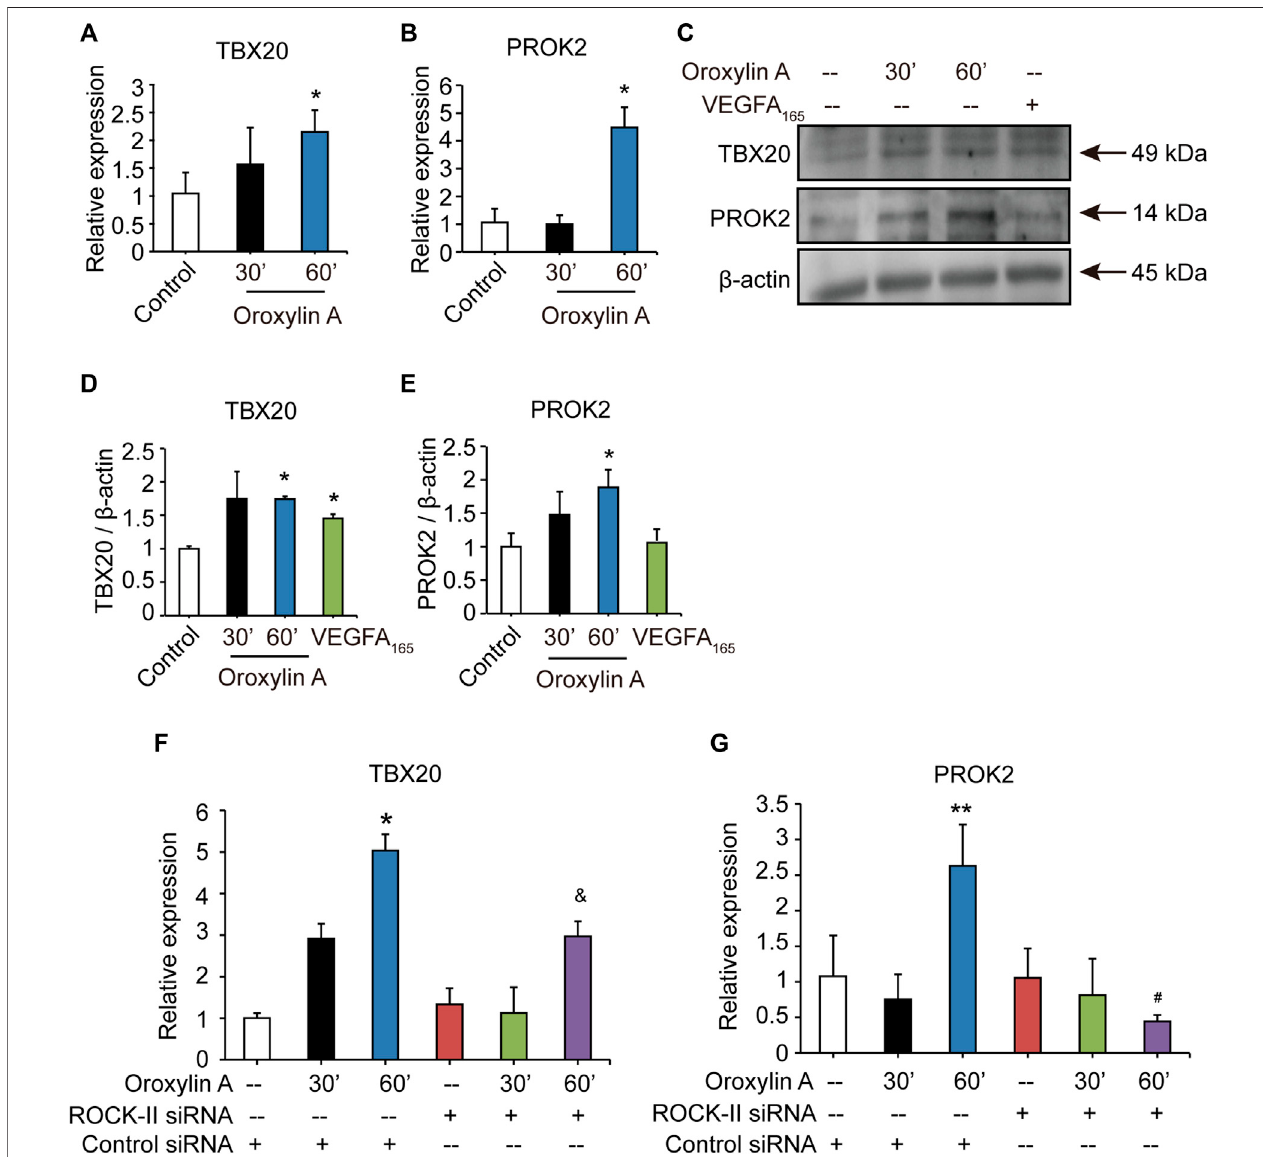
FIGURE 6 | OA regulated TBX20/PROK2 signaling pathway. Western blotting analysis of TBX20 or PROK2 in HUVECs stimulated with DMSO, 2.5 μ M OA (30, 60 min) and VEGFA 165 (100 ng/ml), β -actin expression an internal control of protein loading was performed, with VEGFA 165 as a positive control (A) . Quantitative data included TBX20 (B) and PROK2 (C) . TBX20 (D) and PROK2 (E) mRNA expression in HUVECs treated with DMSO or 2.5 μ M OA for 30, 60 min were analyzed using qRT-PCR.Statisticalanalysisof TBX20 (F) and PROK2 (G) mRNAofHUVECstransfectedwithnon-speci fi csiRNAorROCK-IIsiRNAandstimulatedwithDMSOor 2.5 μ M OA for 30, 60 min were presented. Data were represented as mean ± SD ( n (cid:2) 3). * p < 0.05, ** p < 0.01 vs . control siRNA; & p < 0.05 vs . ROCK-II siRNA; # p < 0.05 vs . control siRNA + OA 60